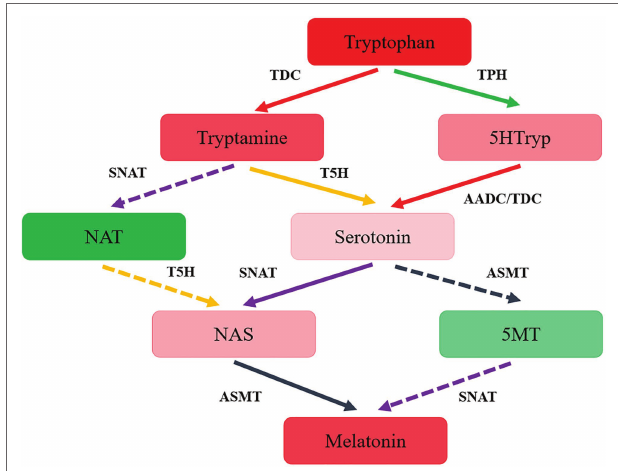
FIGURE 4 | The hypothesized pathway of melatonin biosynthesis in T. guangdongense . 5HTryp, 5-Hydroxytryptophan; NAT, N-acetyltryptamine; NAS, N-acetylserotonin; 5MT, 5-methoxytryptamine; AADC, aromatic-L- amino-acid decarboxylase; TDC, tryptophan decarboxylase; TPH, tryptophan 5-hydroxylase; T5H, tryptamine 5-hydroxylase; SNAT, serotonin N-acetyltransferase; ASMT, acetylserotonin O-methyltransferase; Full line represent the main procedures; colors, the higher degrees of red or green indicate the more or less levels of the intermediate contents,